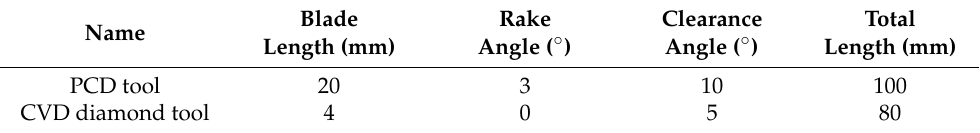
Figure 3. The PCD milling cutter: ( a ) front view; ( b ) side view. Table 2. Tool parameters.